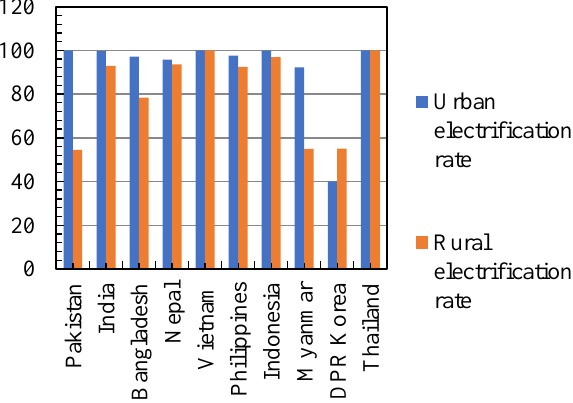
Fig. 5. Rate of electrification in Asian countries.